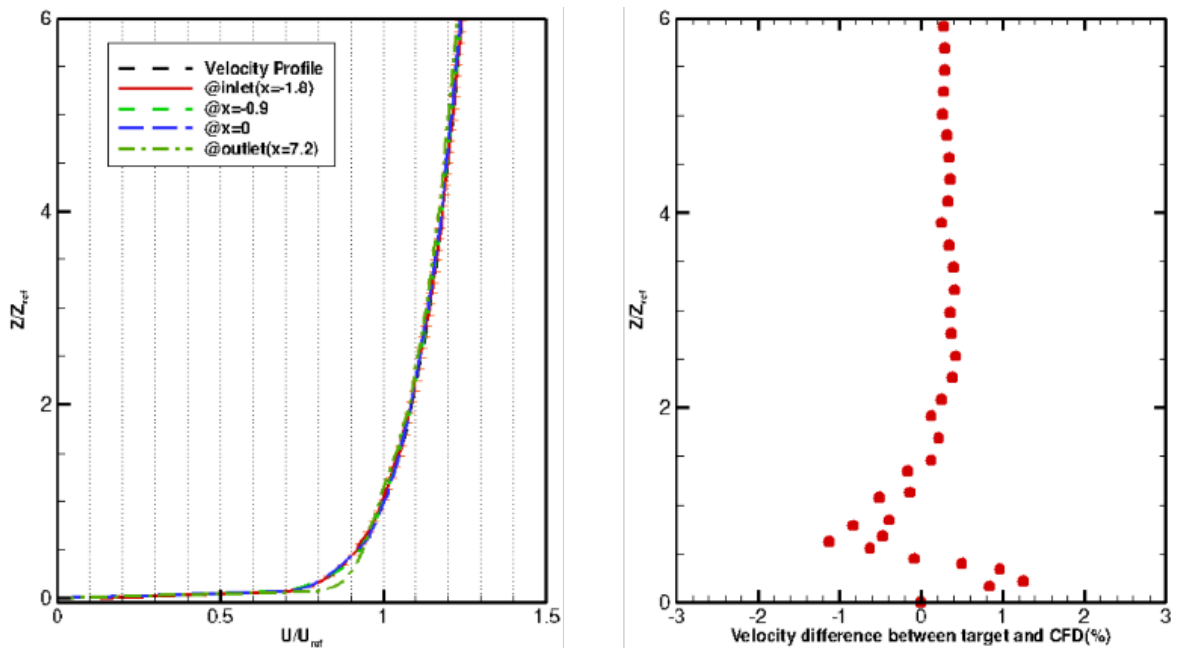
Figure 1. Comparison of velocity profiles employed in the wind tunnel test (dashed black line) and CFD (colored lines) in the ( left panel ), and the difference between the target profile and CFD profile at the center of the domain in the ( right panel ).